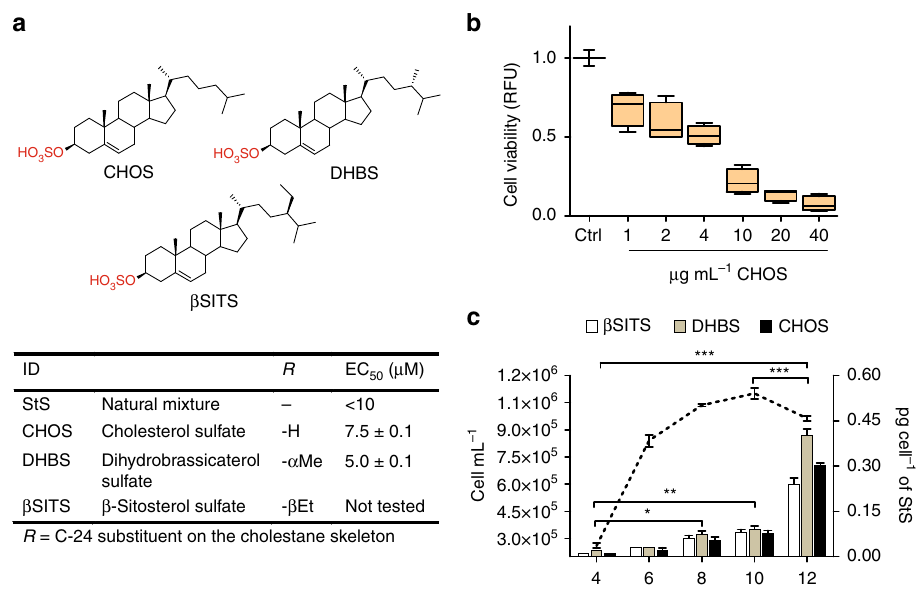
Fig. 2 Structure and inhibitory activity of pure sterol sulfates from S. marinoi . a The diatom S. marinoi contains three main sterol sulfates with structures corresponding to cholesterol sulfate (CHOS), dihydrobrassicasterol sulfate (DHBS), and β -sitosterol sulfate ( β SITS). Natural mixtures of these compounds and the puri fi ed products from S: marinoi extracts were tested ( n = 3) at concentrations ranging from 0.5 to 60 μ g mL − 1 on healthy S. marinoi cells in log phase in 24-well plates for 48 h. EC 50 was calculated by linear regression analysis of the logarithm of product concentration vs. mortality rate using standard curve analysis based on a four-parameter logistic in SigmaPlot 11 software. Data are means ± s.d. of triplicates of two independent experiments. b Average growth inhibition induced by a synthetic standard of CHOS μ g per mL on S. marinoi cells at three different cell densities: 1 × 10 6 , 6 × 10 5 , and 3 × 10 5 cell per mL. Viability at 48 h was determined by the fl uorescein diacetate (FDA) assay. Data (means ± s.d.) of Ctrl (DMSO) and CHOS (1, 2, 4, 10, 20, and 40 μ g mL − 1 ) are expressed as relative fl uorescence units (RFU) ( n = 3). c Growth curve and temporal pattern of StS levels (pg per cell) in S. marinoi cells. StS were quanti fi ed by LCMS, using Cholesterol-25,26,26,26,27,27,27-D 7 Sulfate as internal standard. Data are means ± s.d. of triplicates of